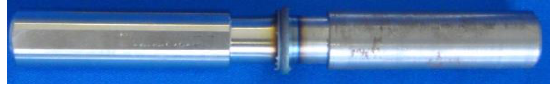
Table 3. Cutting conditions for machining experiments.